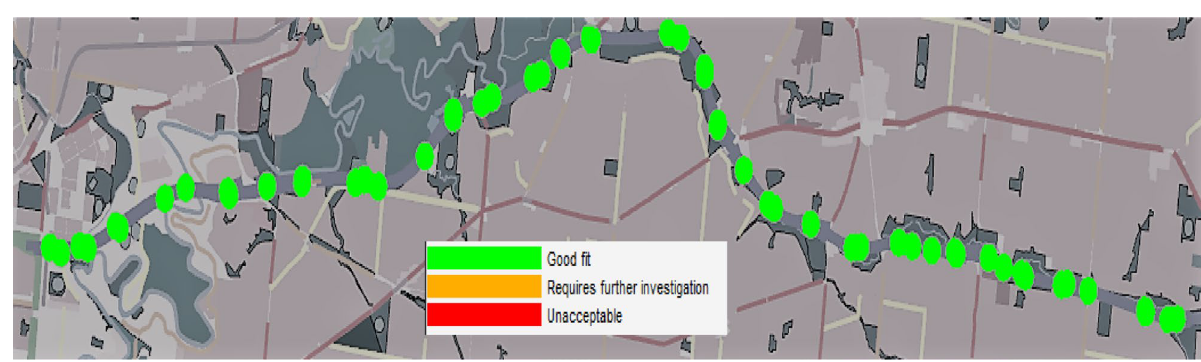
Figure 2. Traffic flow calibration results.